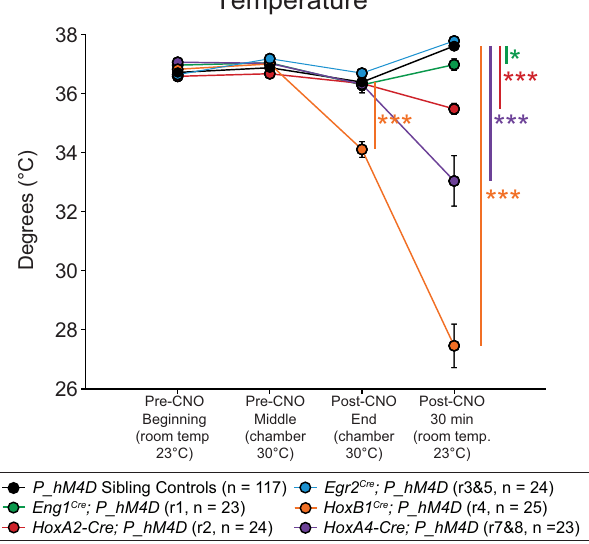
Figure 6. CNO-hM4D perturbation of rhombomeric domains in the adult animal results in significant reductions in body temperature. Temperature was taken at the start of respiratory assays (Pre-CNO Beginning), immediately before CNO injection (Pre-CNO Middle), at the end of respiratory assays (Post-CNO End), and 30 minutes at room temperature after the end of the assay (Post-CNO 30 min). Statistical significance was determined using a linear mixed-effects regression model with animal type (experimental or control) as a fixed effect. * p < 0.05, ** p < 0.01, *** p <